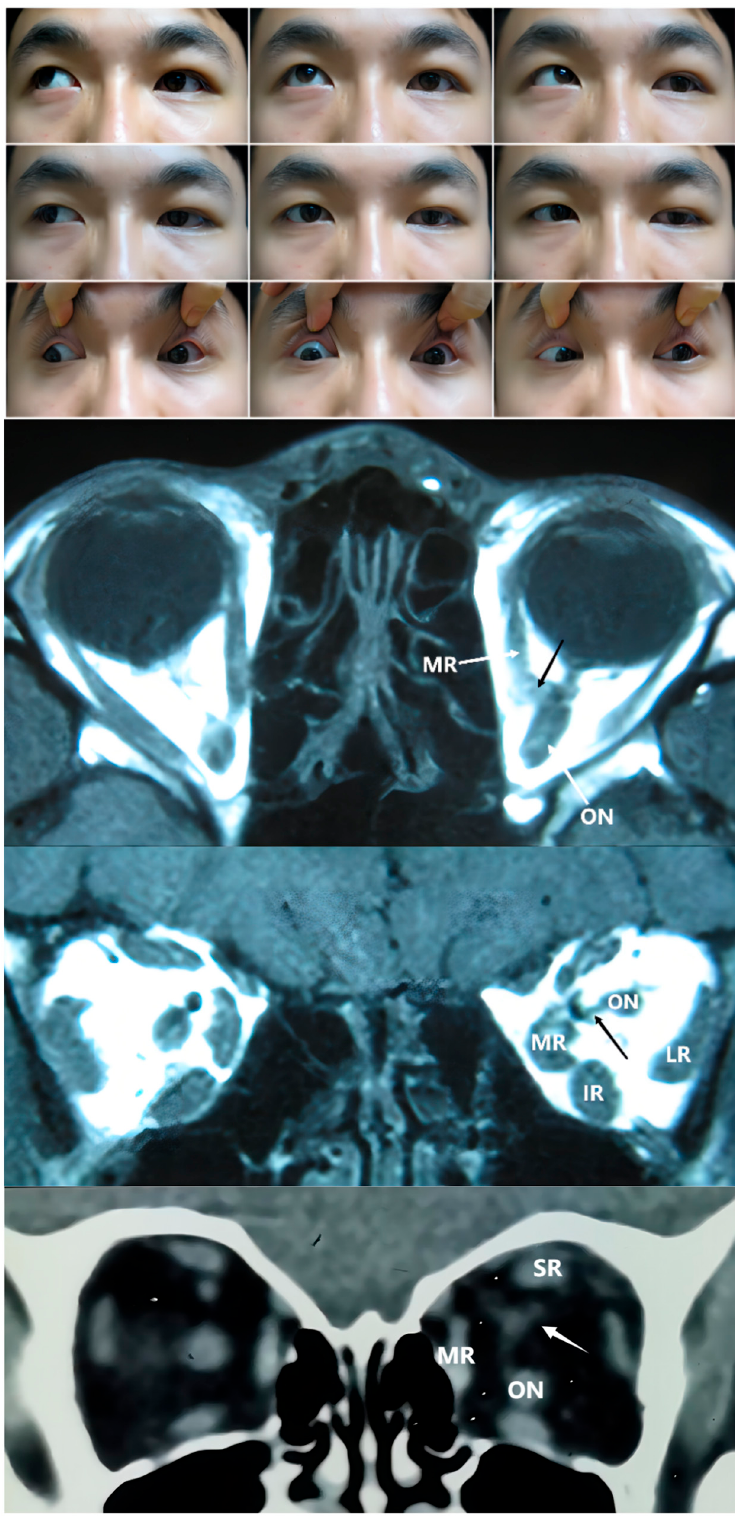
Figure 4. Upper Panel: Nine gaze photograph of Case 11 showing a 13 PD exotropia and 13 PD left hypotropia. Ocular motility determinations revealed differences in the extent of limitations in all directions. Second Panel: T1 coronal MRI of Case 11 demonstrating a muscular band between the medial rectus (MR) and optic nerve (ON) in the left orbit. Third Panel : T1 axial MRI of Case 11 showing connections. Bottom Panel: coronal CT of Case 12 showing a muscular band between the superior rectus (SR) and optic nerve in the left orbit. IR: inferior rectus; LR: lateral rectus.